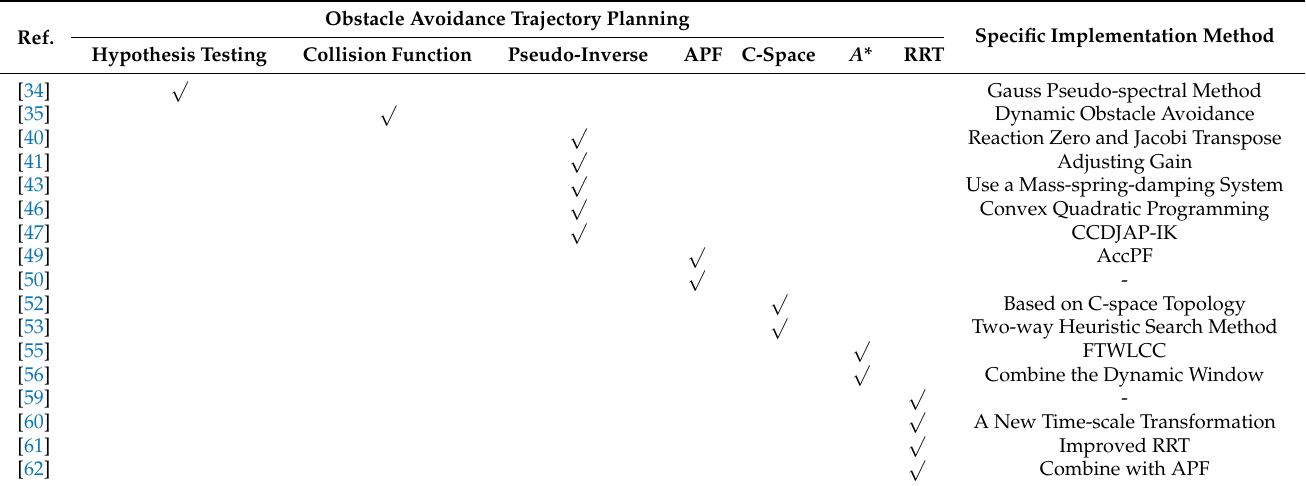
Table 1. Summary of spatial robotic arm obstacle avoidance planning study.